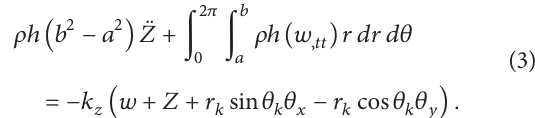
Figure 4: Spinning disk with free inner and outer boundary condi- tions, with rigid body tilting and translational motions, constrained by a lateral spring.